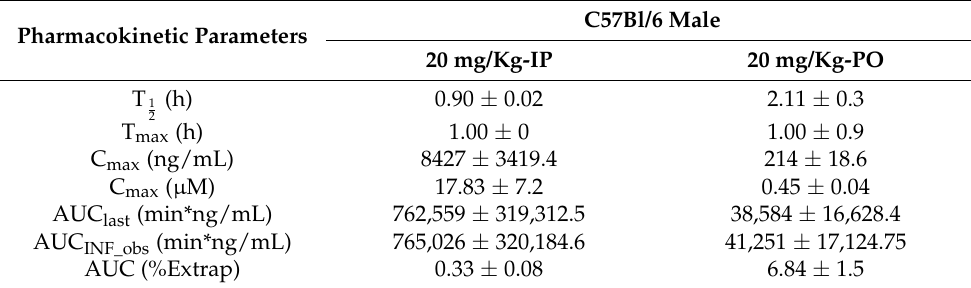
Table 2. Pharmacokinetics parameters of momordicine I (M-I) administered either through